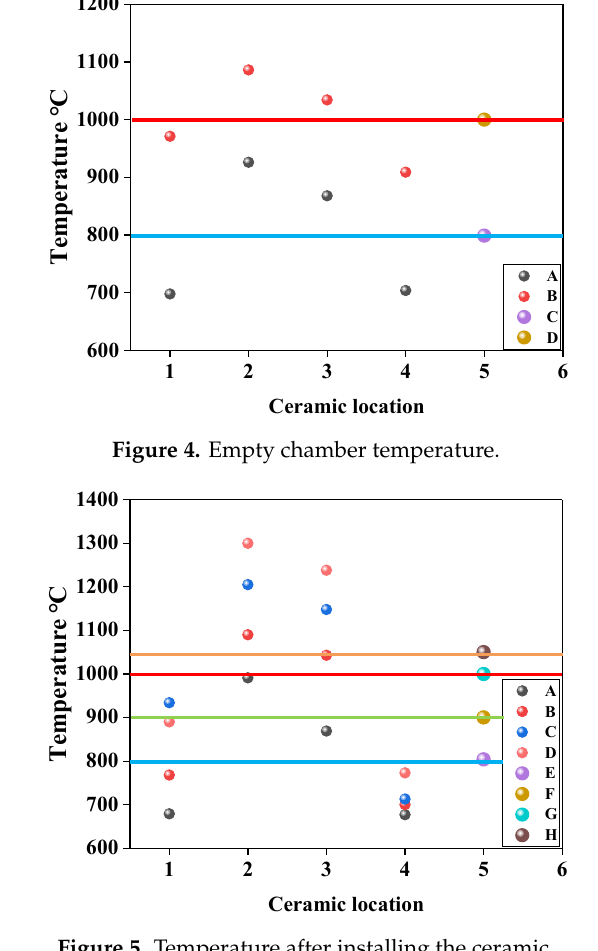
Figure 5. Temperature after installing the ceramic.